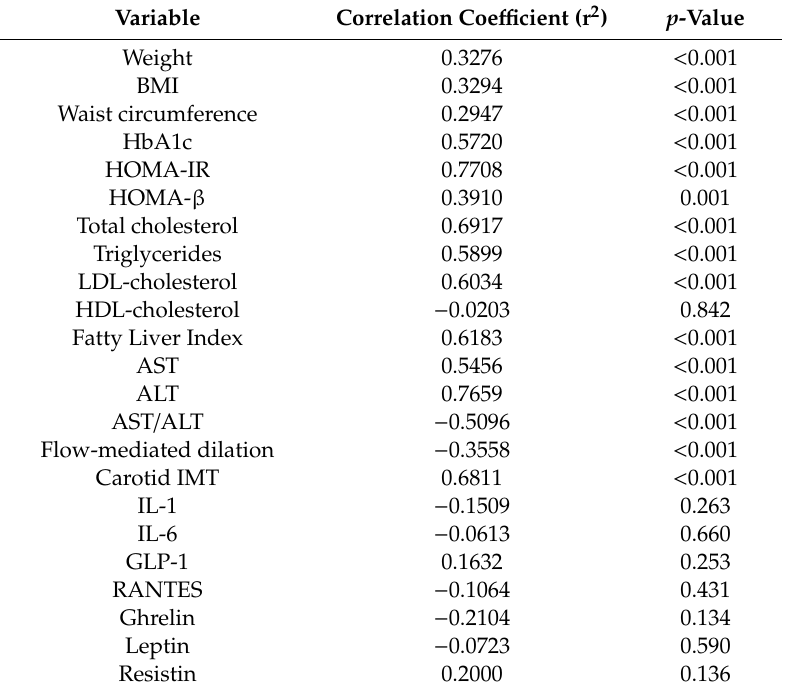
Table 5. Pearson’s correlation analysis of the variables between the study groups ( n =